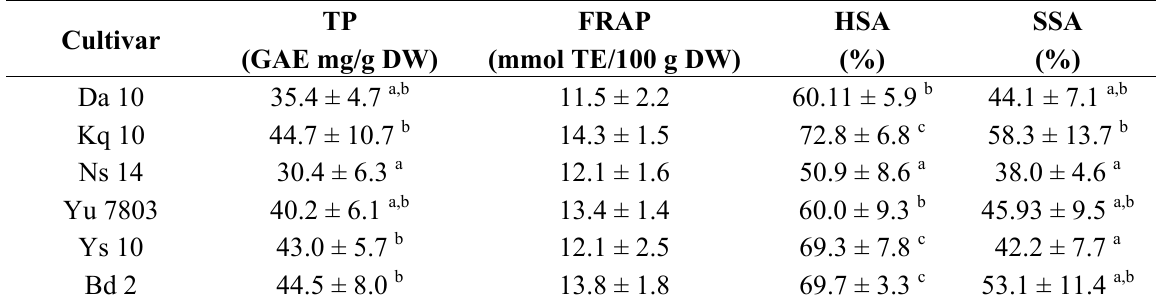
Table 2. Effect of cultivar on TP content and antioxidant activity of mulberry